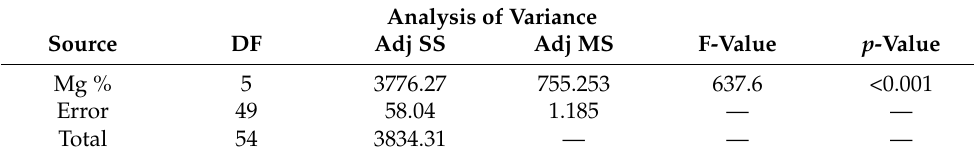
Table 9. One-way ANOVA for the effect of Mg percentage on the electrical conductivity.